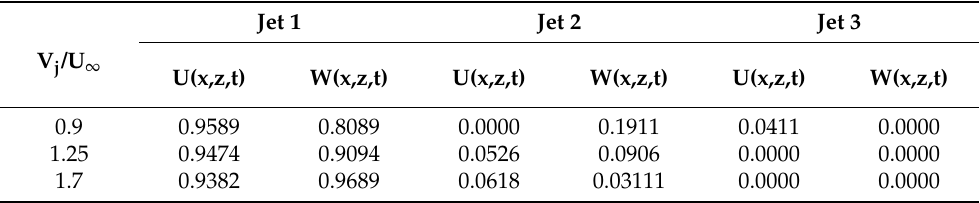
Table 1. Optimal velocity component weightings for each composite jet at each jet to crossflow velocity